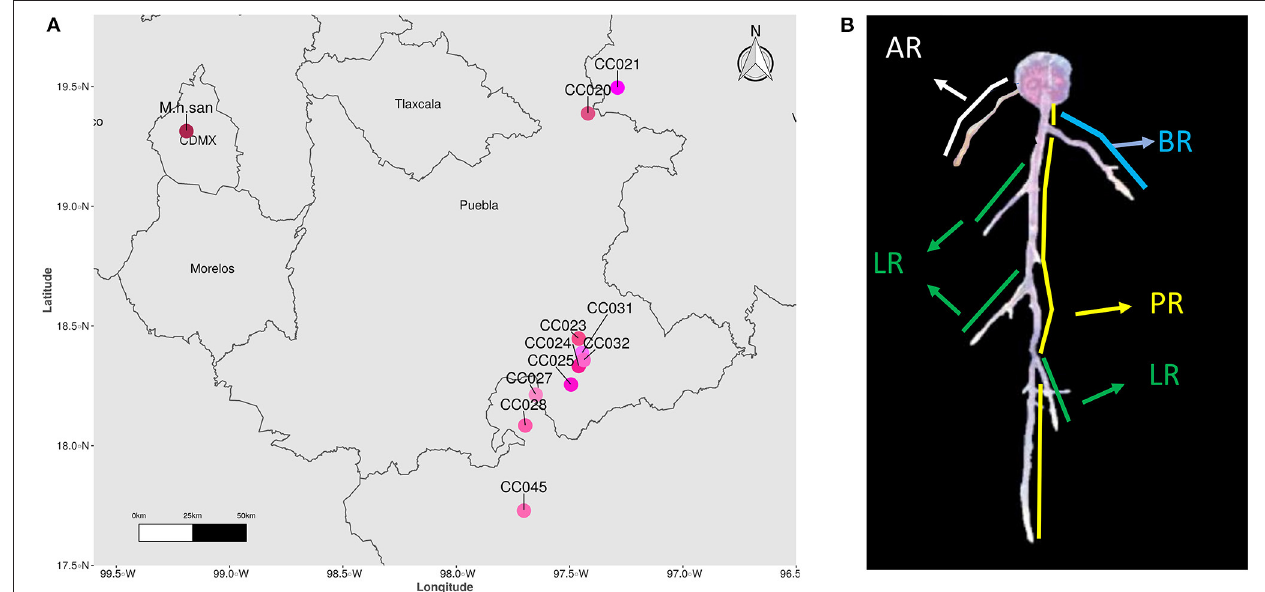
FIGURE 1 | (A) Geographical origin of M. haageana accessions. (B) Characterization of root attributes in a Mammillaria plant. PR, Principal Root; LR, Lateral Root; BR, Basal Root; AR, Adventitious